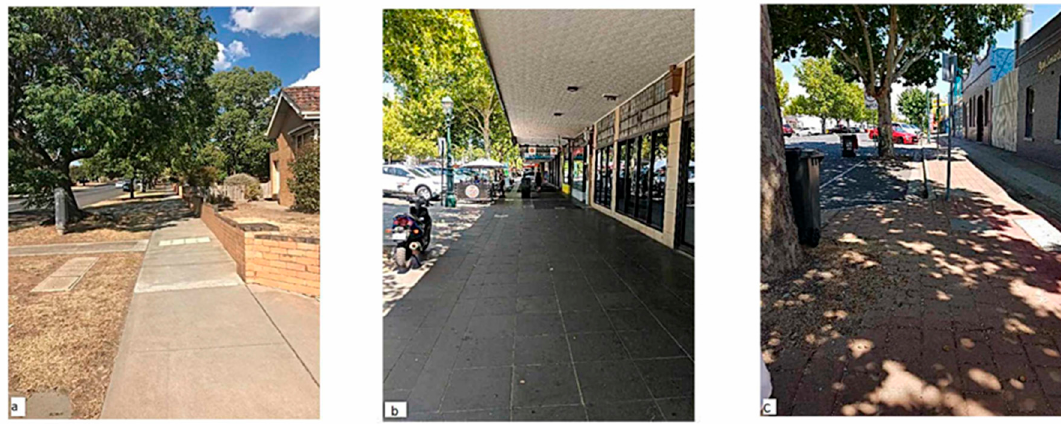
Figure 1. Images of natural ( a ), built ( b ) and amalgam Shadeways ( c ).